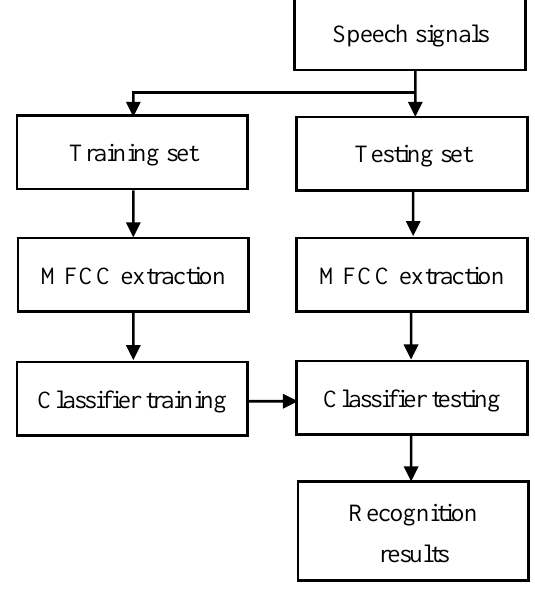
Figure 5. Speech emotion recognition procedure.